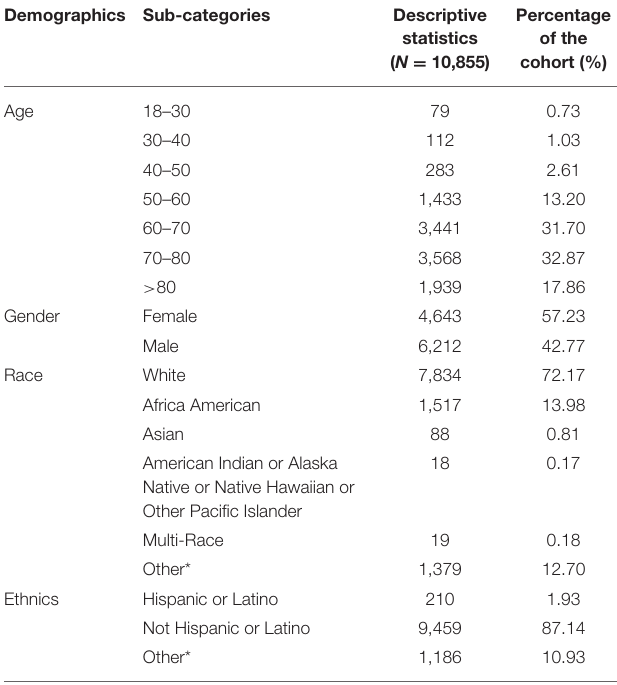
TABLE 1 | Summary of statistics for the lung cancer cohort.